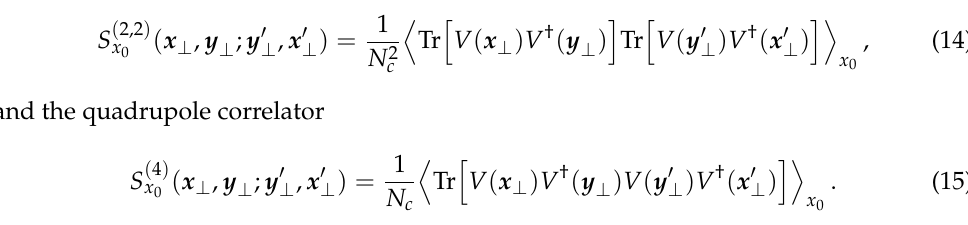
Figure 4. Feynman diagram for the forward scattering amplitude nucleus collision. The amplitude contains two light-like Wilson lines, which appear from the interaction of the quark anti-quark pair with the nucleus. This amplitude is related to the total DIS cross section by virtue of the optical theorem σ γ ∗ A = 2Im ( forward amplitude is purely